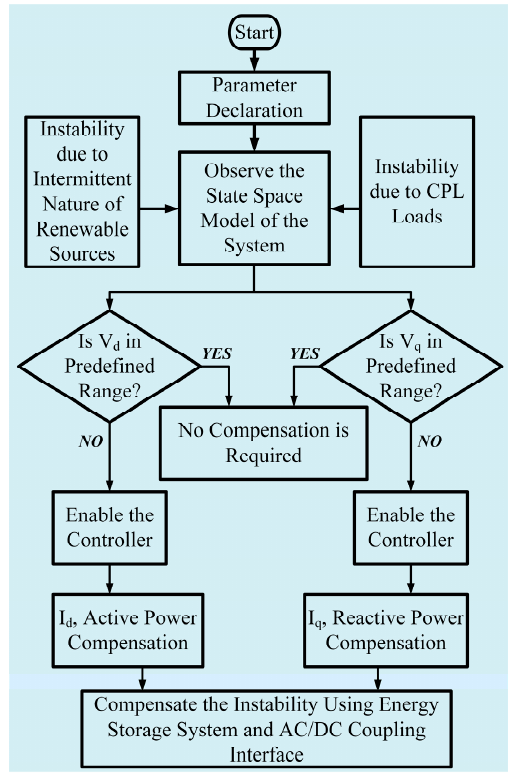
Figure 14. Algorithm for sliding mode control of a microgrid with CPL.